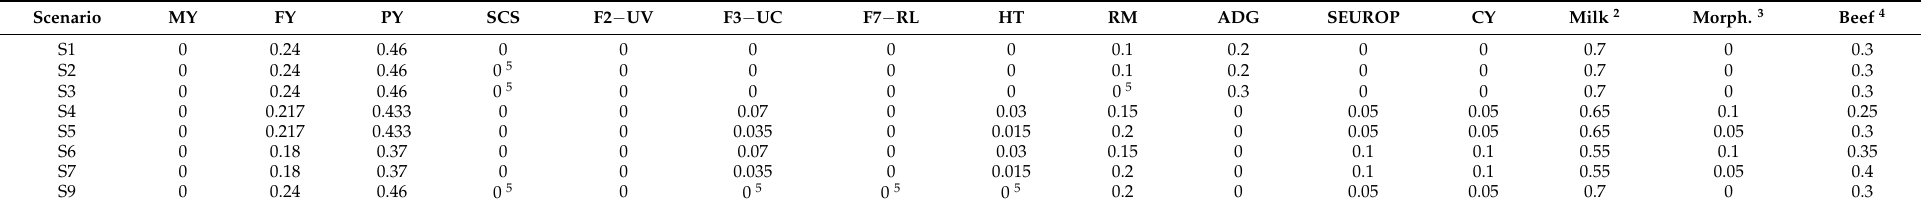
Table 5. Economic weights of traits as applied before the restriction for the genetic progress of target traits 1 . The sum to 1 of the economic weights of traits considers the absolute values of the weights.